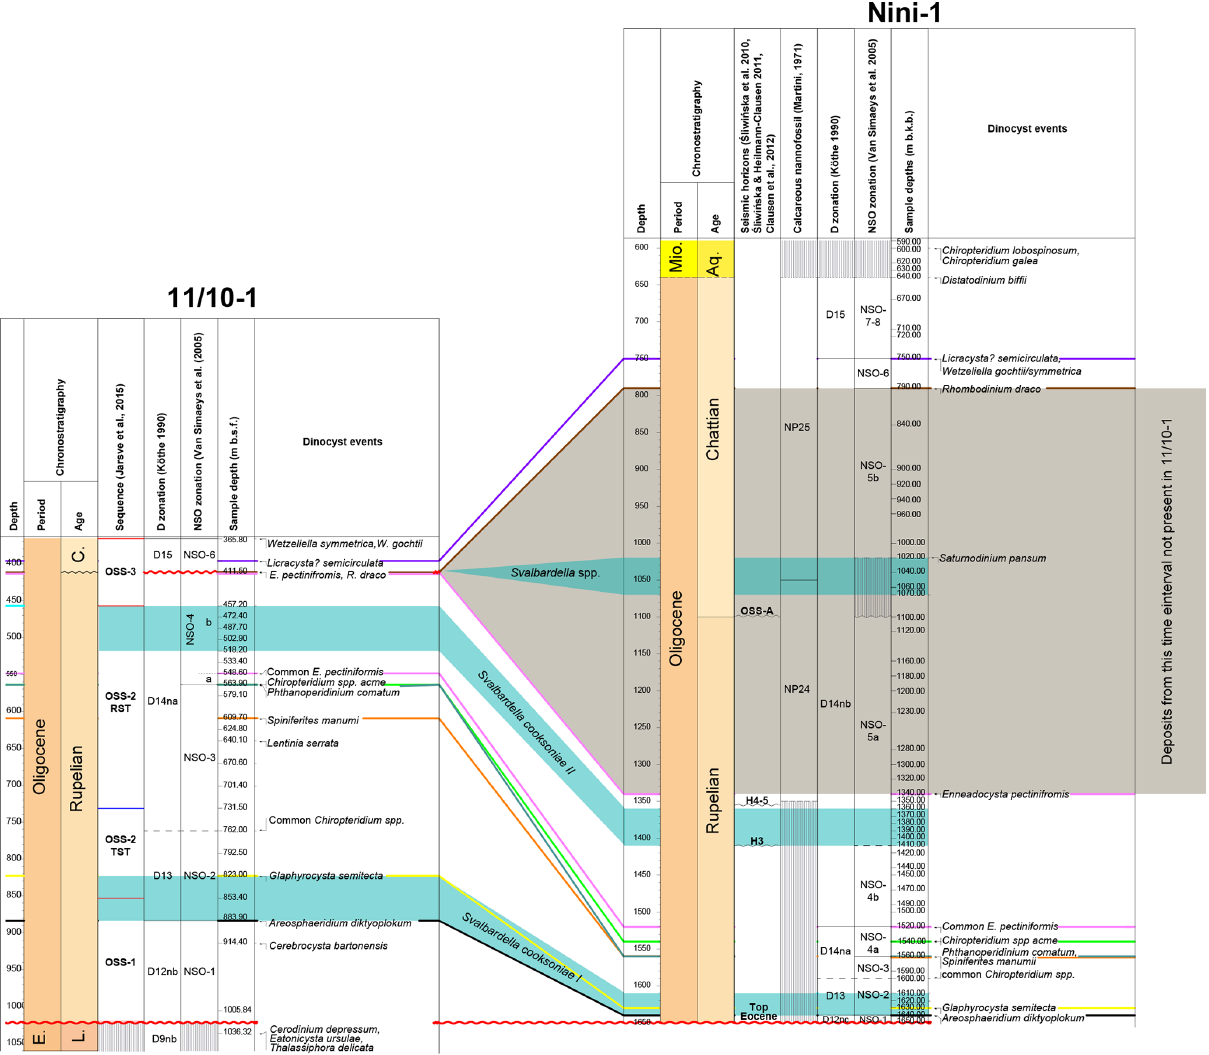
Figure 6. Correlation between the 11/10-1 and the Nini-1 well. Nini-1: distribution of the NP zones after ´Sliwi´nska et al. (2014); dinocyst events after ´Sliwi´nska (2009), ´Sliwi´nska et al. (2010), ´Sliwi´nska and Heilmann-Clausen (2011), and Clausen et al. (2012); and the key seismic sequences and surfaces after ´Sliwi´nska et al. (2010) and Clausen et al. (2012). C. – Chattian. E. – Eocene. L. – Lutetian. Mio. – Miocene. Aq. –